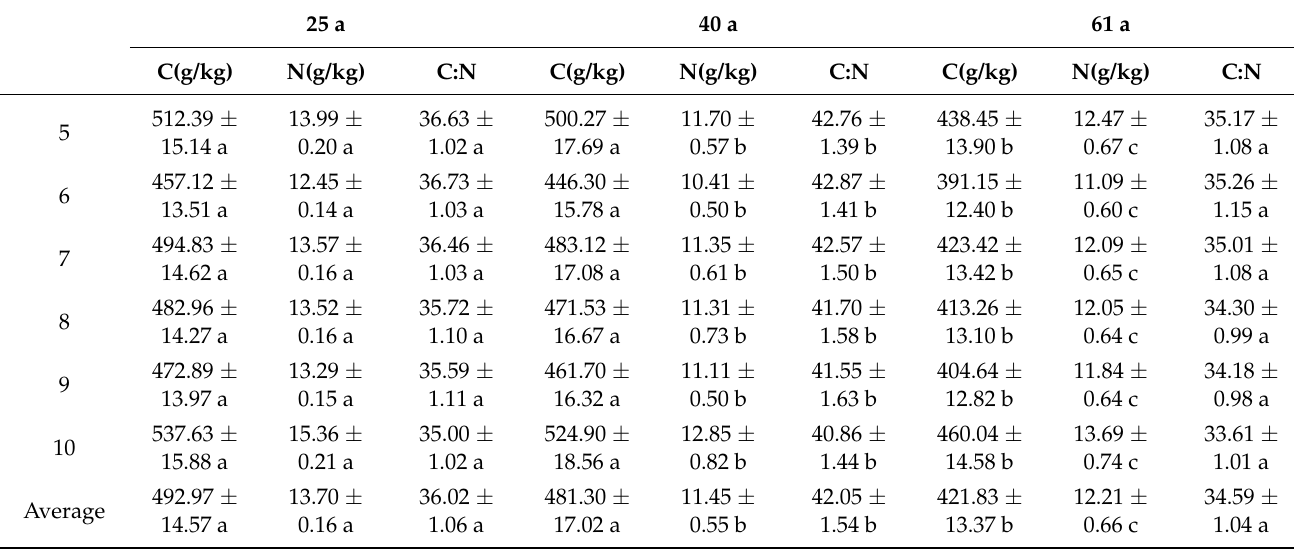
Table A1. Chemical properties of the litter in Betula platuphylla forests of the permafrost region, Northeast China.